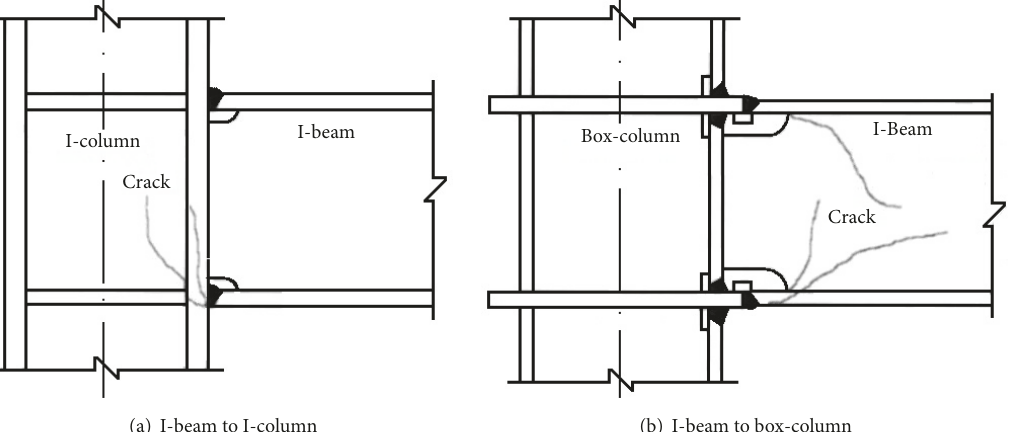
Figure 1: Fracture of beam-to-column welded